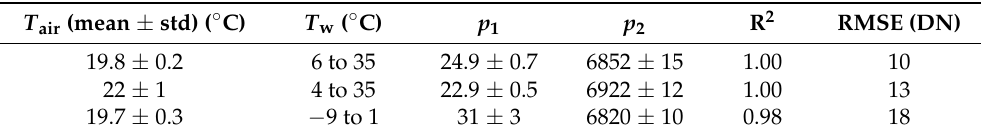
Table 3. Curve fitting results of DN as a function of T w to p 1 x + p 2 , derived in the laboratory, with T air and T w measured using handheld sensors. Std is standard deviation of the mean and RMSE root- mean-square-error of the